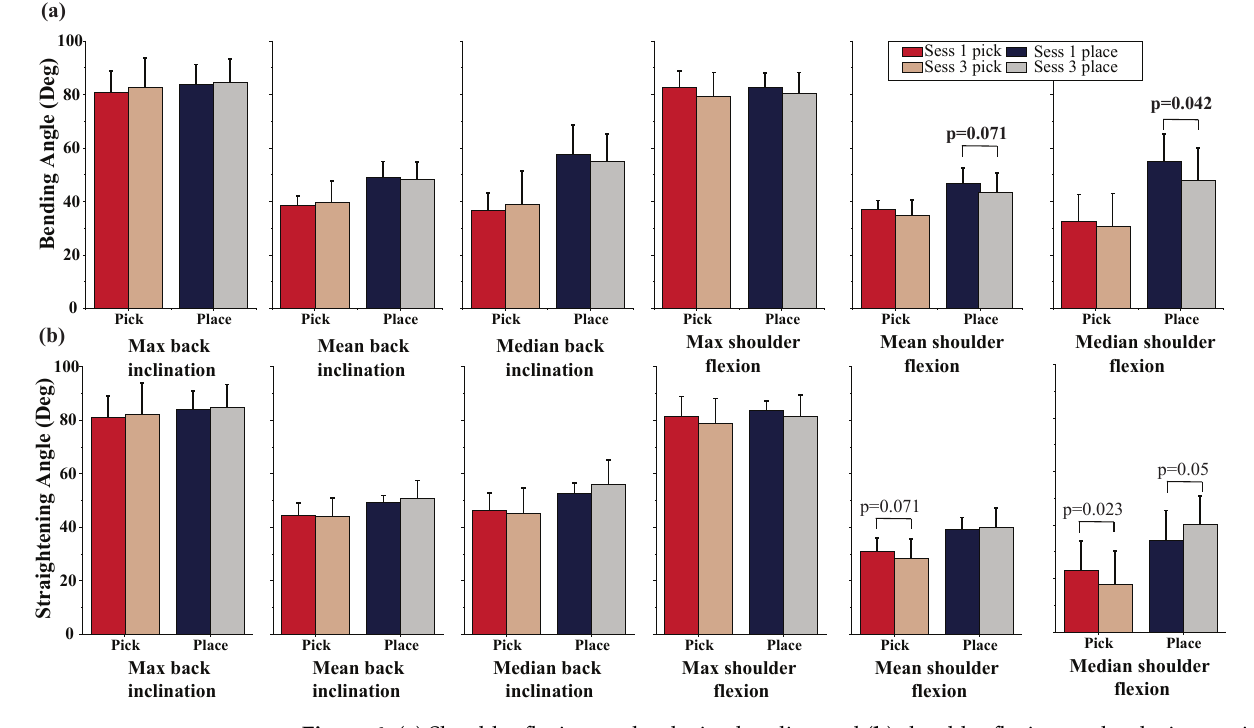
Figure 6. ( a ) Shoulder flexion angles during bending and ( b ) shoulder flexion angles during straight- ening are compared between the first and last sessions during picking and placing.